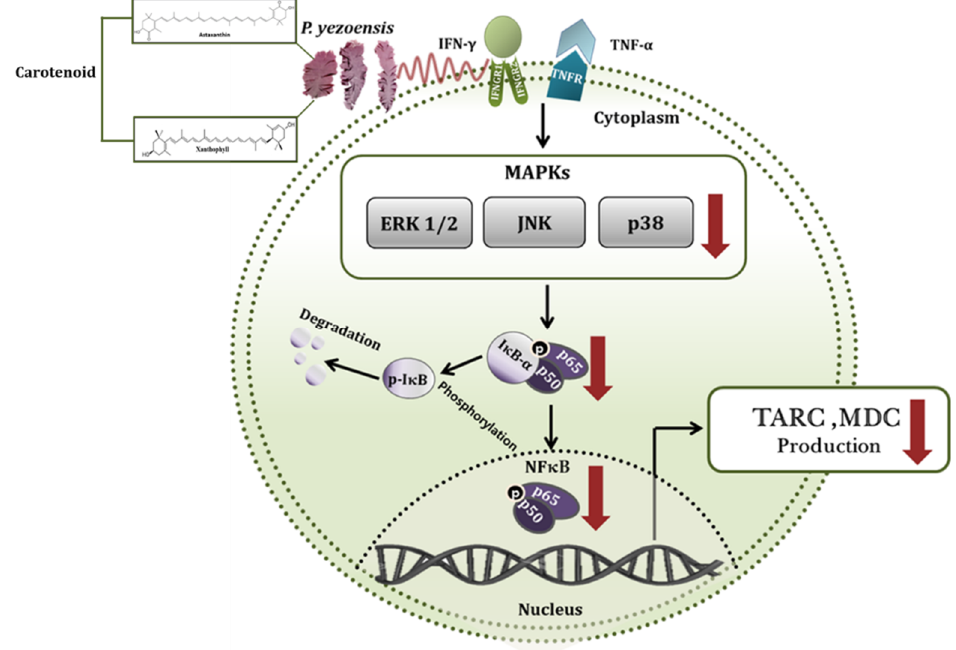
Figure 8. Schematic inhibitory signaling pathway of P. yezoensis extract (PYE) on interferon (IFN)-γ- and tumor necrosis factor (TNF)-α-induced TARC and MDC production in human keratinocytes. Red poly line arrows indicate the activity of P. yezoensis extract (PYE) and black arrows indicate the induction of cytokines.